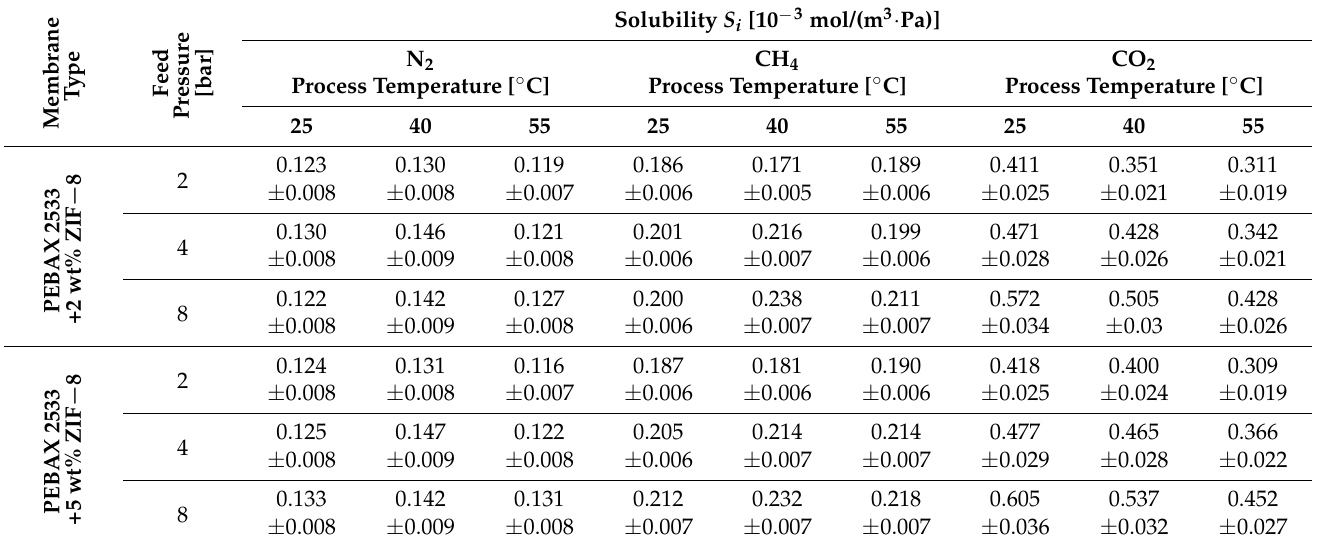
Table A11. Solubility coefficient of heterogeneous membranes containing ZIF − 8 to different gases measured for different feed pressure and temperature values.